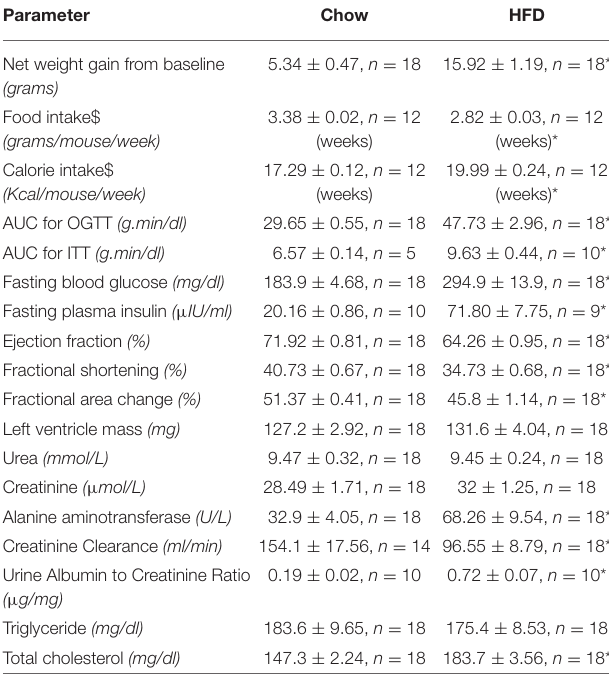
TABLE 1 | Baseline data for both chow and HFD groups before interventions (CLP or sham surgeries).